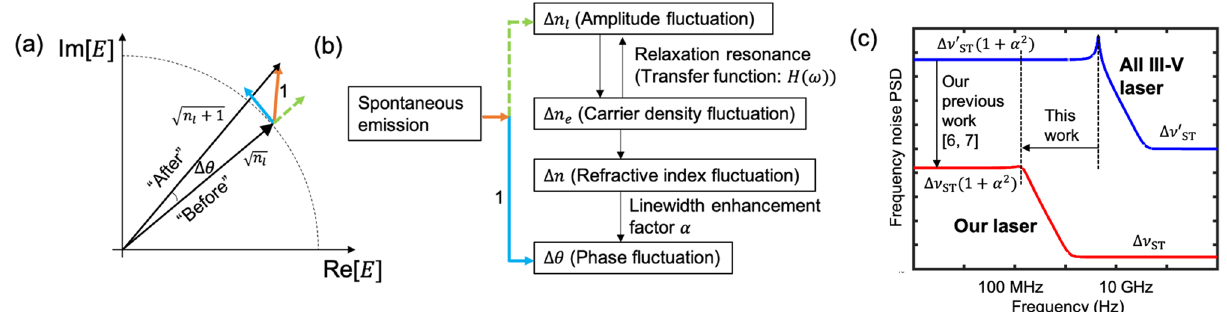
Figure 1. ( a ) The phasor model for the laser field phase, showing the electric field before and after a single spontaneous emission event (orange arrow). The projection of the spontaneous emission event onto the phase and intensity quadrature is shown in the blue solid and green dotted line respectively. ( b ) Phase noise due to spontaneous emission including both the direct spontaneous emission phase noise and the additional phase noise via the amplitude-phase coupling. ( c ) A cartoon illustrating the changes to the frequency noise power spectral density of the high-coherence Silicon/III–V laser studied as part of this work and the